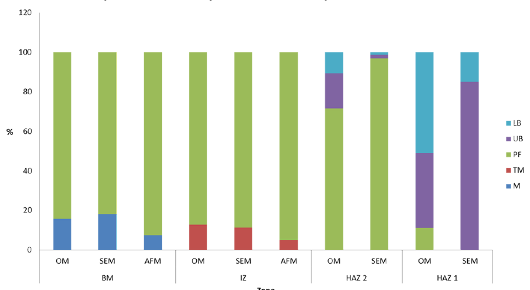
Figure 3. Image analysis results of OM compared with the ones found by SEM and AFM in various welded regions.